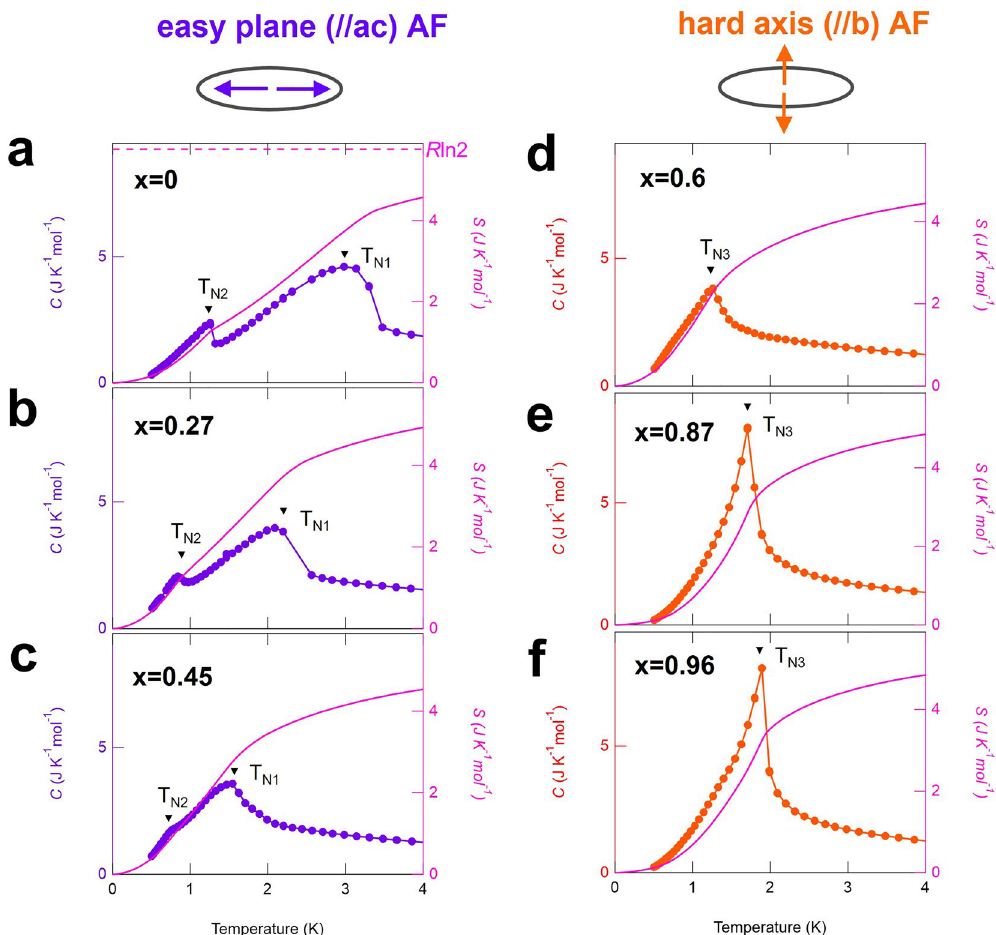
Figure 3. Doping and temperature dependence of heat capacity C ( T ) of Ce(Se x Te 1− x )Te 2 . ( a – f ) Temperature dependence of the heat capacity (circles; left axis) and magnetic entropy (solid line; right axis) of ( a ) x = 0, ( b ) x = 0.27, ( c ) x = 0.45, ( d ) x = 0.60, ( e ) x = 0.87, ( f ) x = 0.96. The purple color represents data obtained from samples with easy plane antiferromagnetism (AF), and the orange represents those with hard axis AF. In ( a ), the value R ln2 (~ 5.76 JK −1 mol −1 ) is shown with a broken line. This value is the calculated magnetic entropy from the ground state doublet of Ce 3+ ions under the crystalline electric